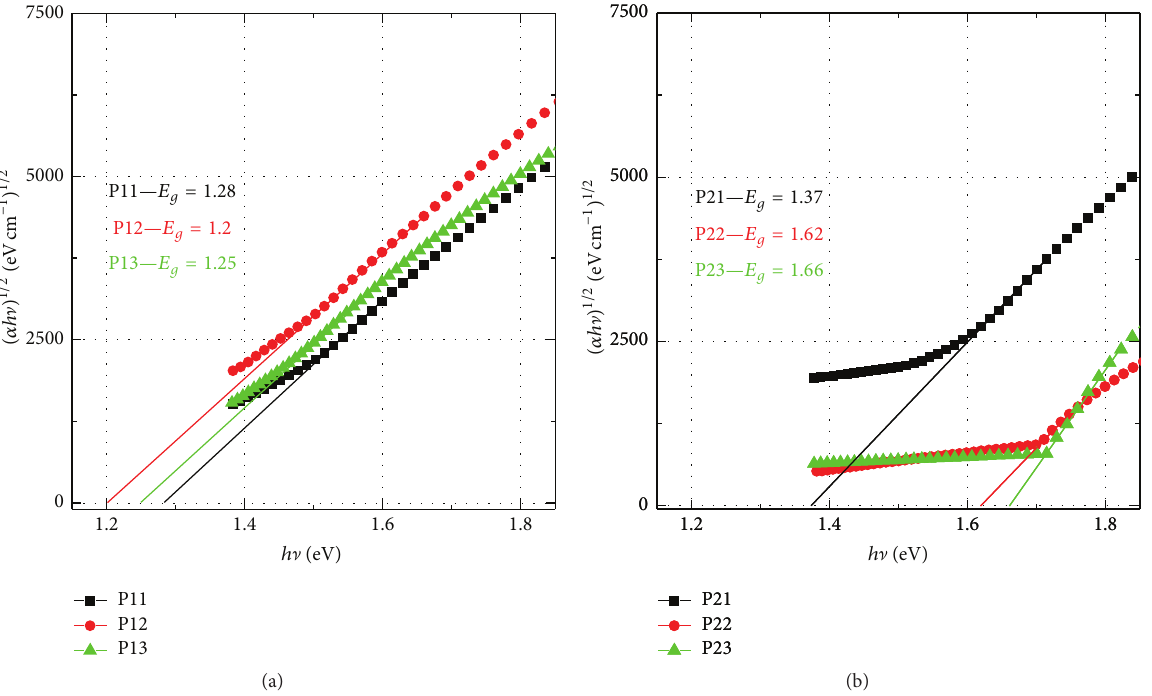
Figure 6: Tauc plot obtained from UV-Vis measurements for extracting the band gap ( 𝐸 𝑔 ) in two series of pm-Si 𝑥 Ge 𝑦 :H films. (a) Series #1: SiH 4 /GeH 4 = 1 and (b) Series #2: SiH 4 /GeH 4 = 9.